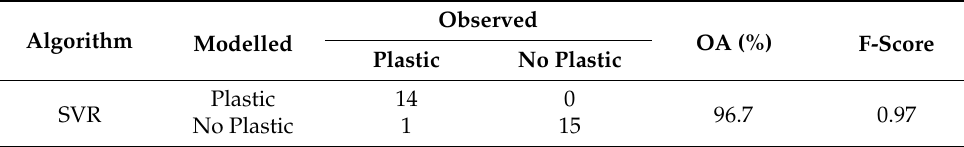
Figure 5. Predicted grids with/without presence of floating plastics for validation data obtained using K-means unsu- pervised clustering, fuzzy c-means (FCM) unsupervised clustering, support vector regression(SVR)-based supervised classification, and semi-supervised fuzzy c-means (SFCM) classification algorithms using attribute sets ( A – C ), given in Table 3. TP (true positive) indicates that the model correctly detects the presence of floating plastics, TN (true negative) indicates the model correctly predicts the absence of floating plastics, FP (false positive) means the model wrongly detects the presence of floating plastic when in reality the grid is plastic free, while FN (false negative) indicates the algorithm fails to detect floating plastics. Table 6. Error matrix, overall accuracy (OA), and F-score obtained from the SVR model using the validation data consisting of 30